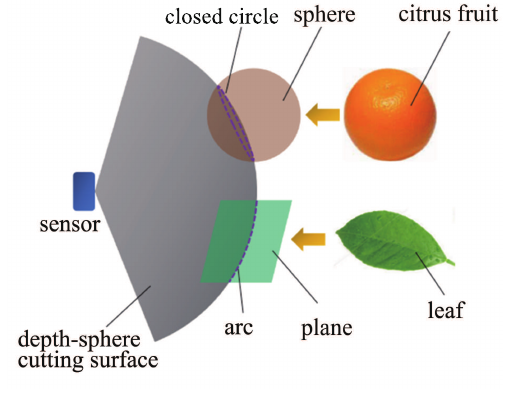
Figure 5. Depth-sphere cutting theory.